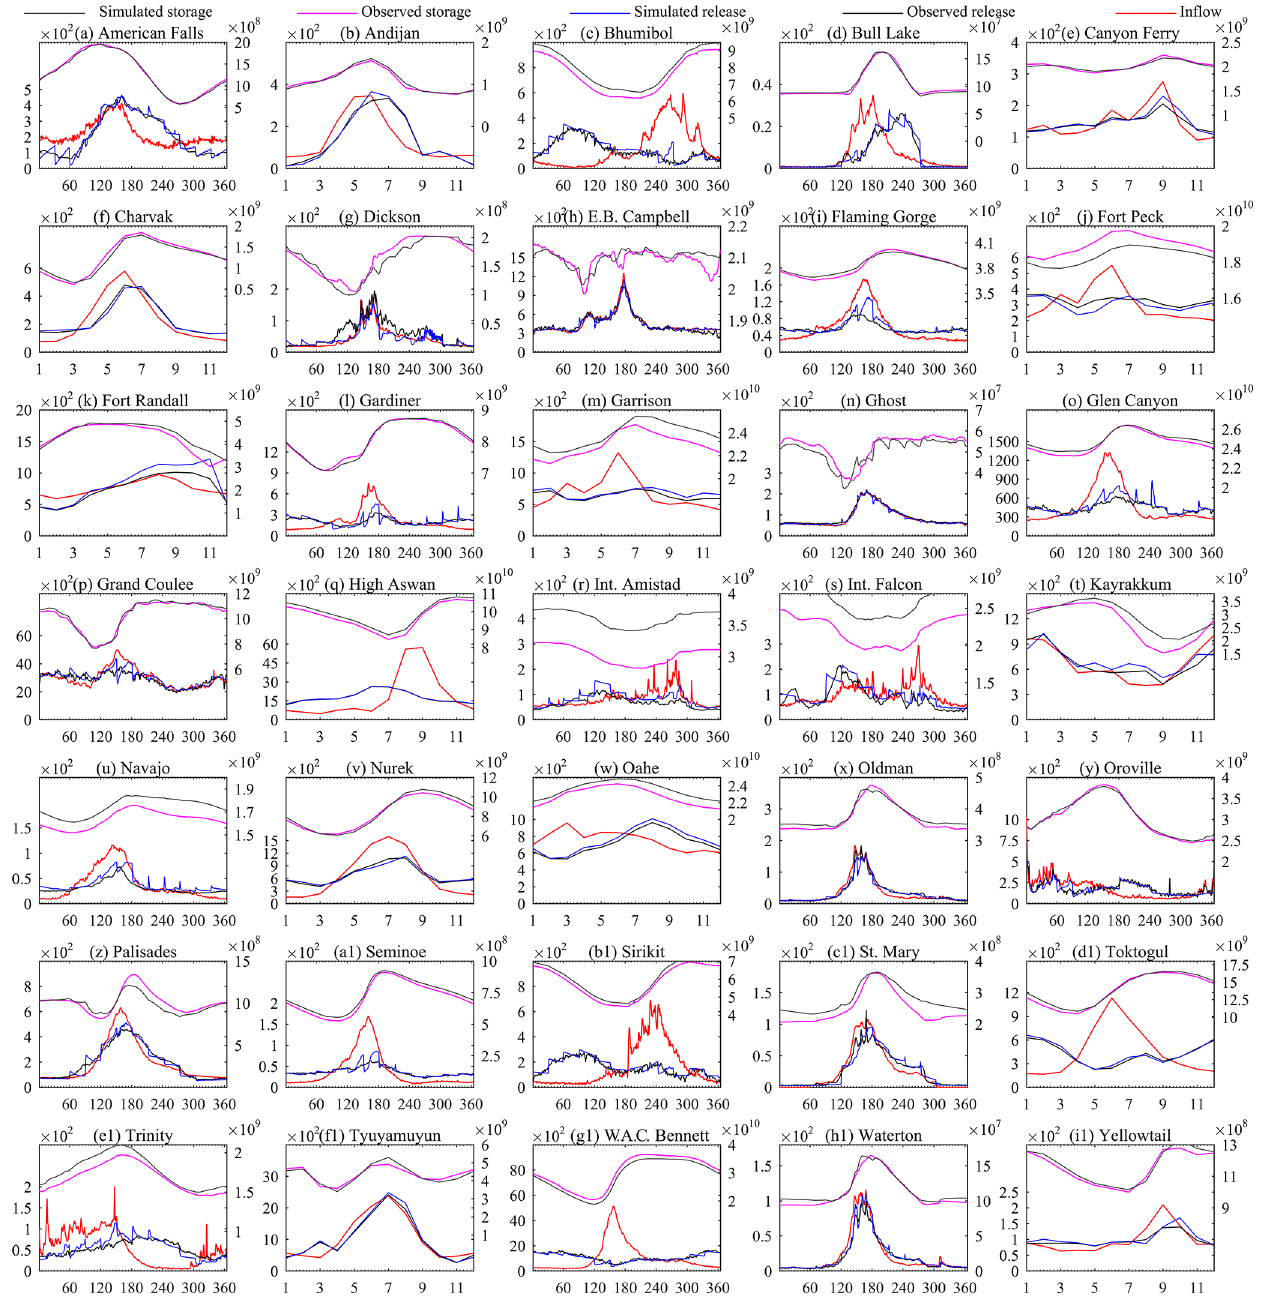
Figure 7. Long-term average daily or monthly reservoir simulations with generalized parameterization; the x axes show days (1–365) or months (1–12), the primary y axes show release (m 3 s − 1 ), and the secondary y axis shows storage (m 3